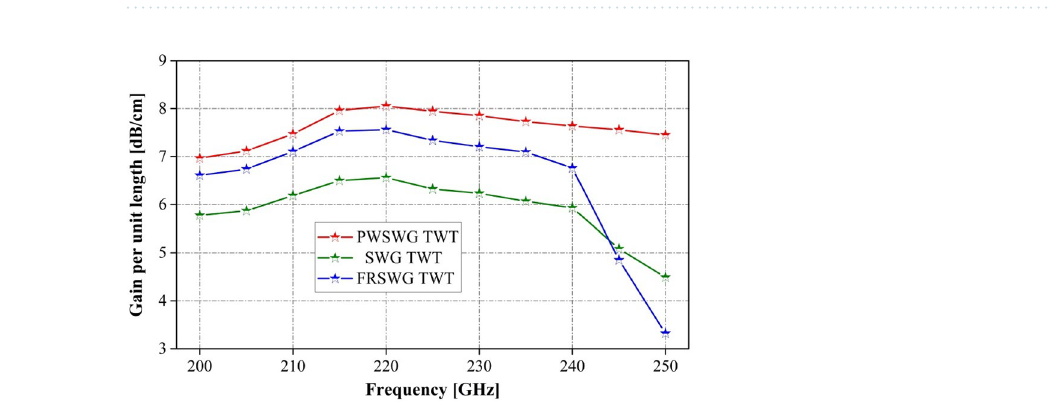
Figure 16. Comparison of output power of the PWSWG TWT, the SWG TWT and the FRSWG TWT.